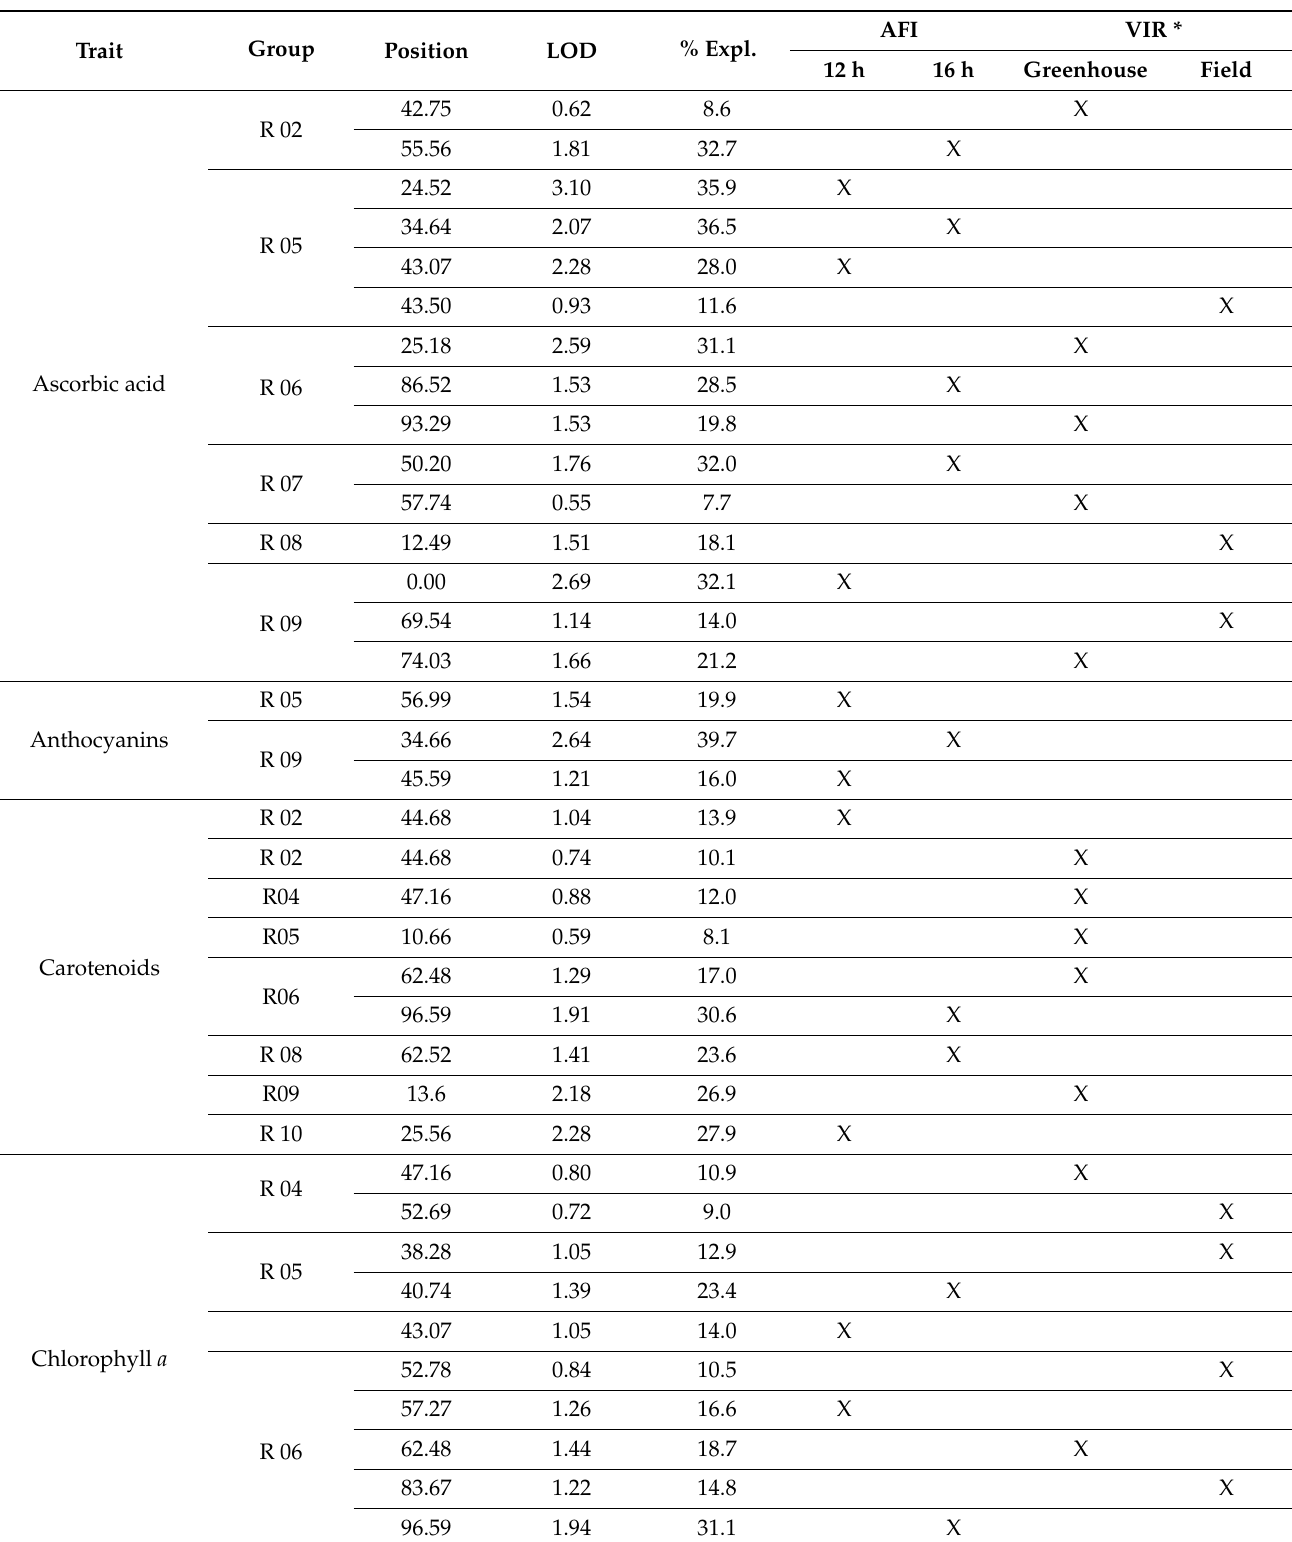
Table 4. QTL mapping of loci that determine the content of biologically active substances and nutrients in the mapping population DH